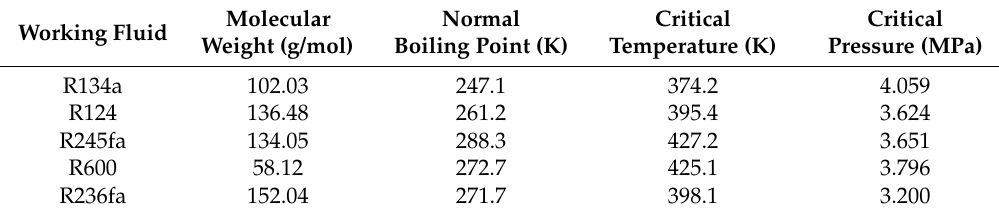
Table 2. Properties of the selected low-temperature working fluid